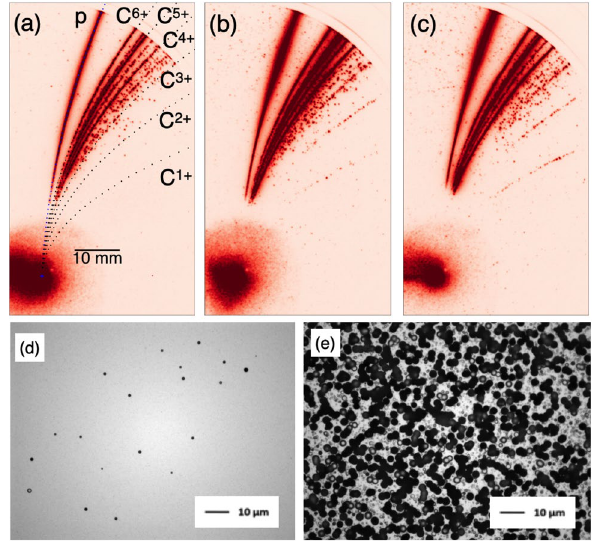
Figure 4. High contrast best focus shots: reproducibility. Three successive nominally identical shots with 8-layer LSG: ( a ) the same shot as in Fig. 3c, 19.3 J, 4.83 × 10 21 W cm − 2 , a 0 = 47.9 , ( b ) 18.2 J, 4.55 × 10 21 W cm − 2 , a 0 = 46.6 , and ( c ) 19.2 J, 4.81 × 10 21 W cm − 2 , a 0 = 47.8 . The ion pits on CR-39 in stack detector: ( d ) range between 14 and 94